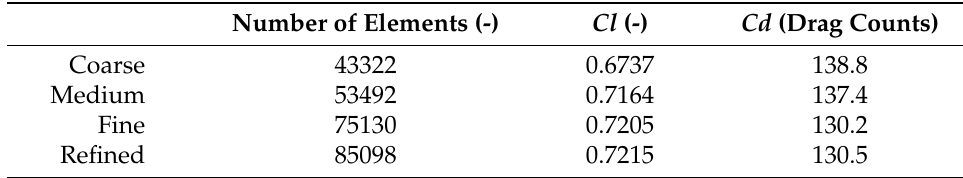
Table 1. Mesh convergence study for the CFD simulations.